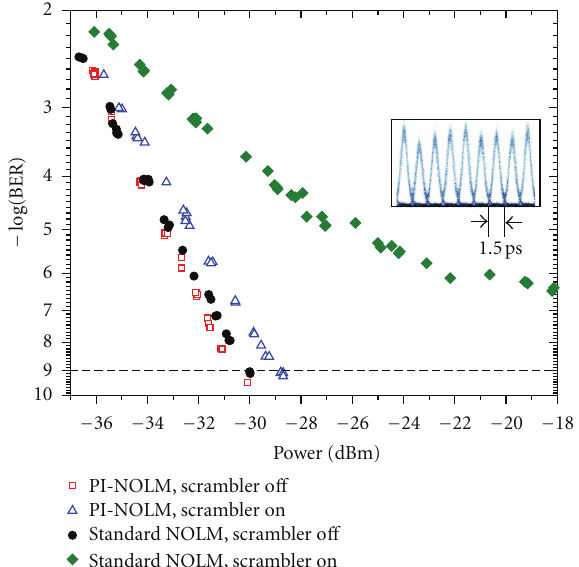
Figure 20: BER curves for the standard and PI-NOLM operation. Inside: 640Gbit/s eye